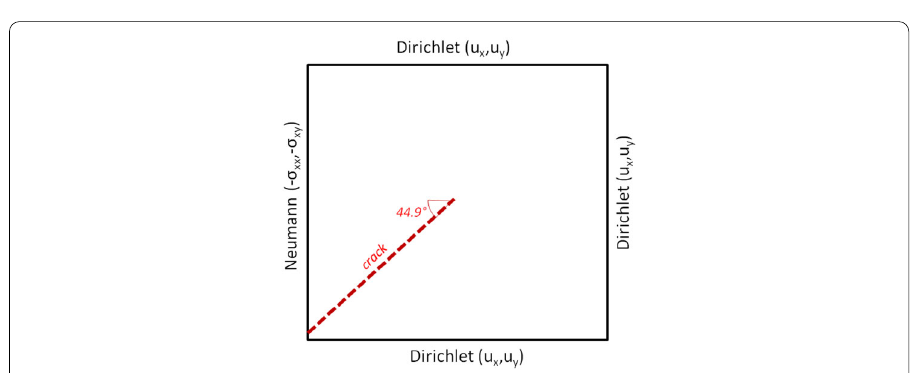
Fig. 23 Analytical solution corresponding to a mode 1 displacement field for the inclined crack